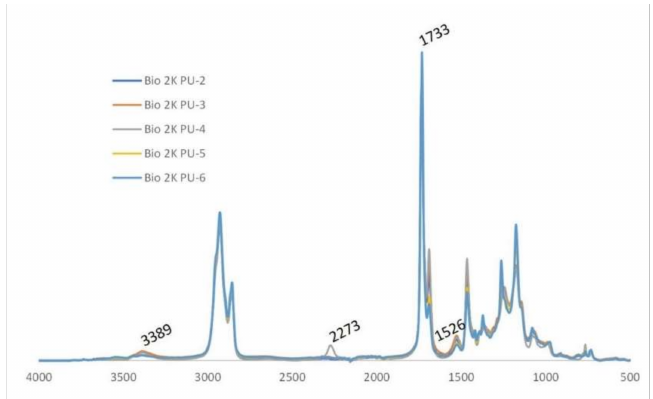
Figure 3. FT-IR spectra of Bio 2K PU-2, Bio 2K PU-3, Bio 2K PU-4, Bio 2K PU-5 and Bio 2K